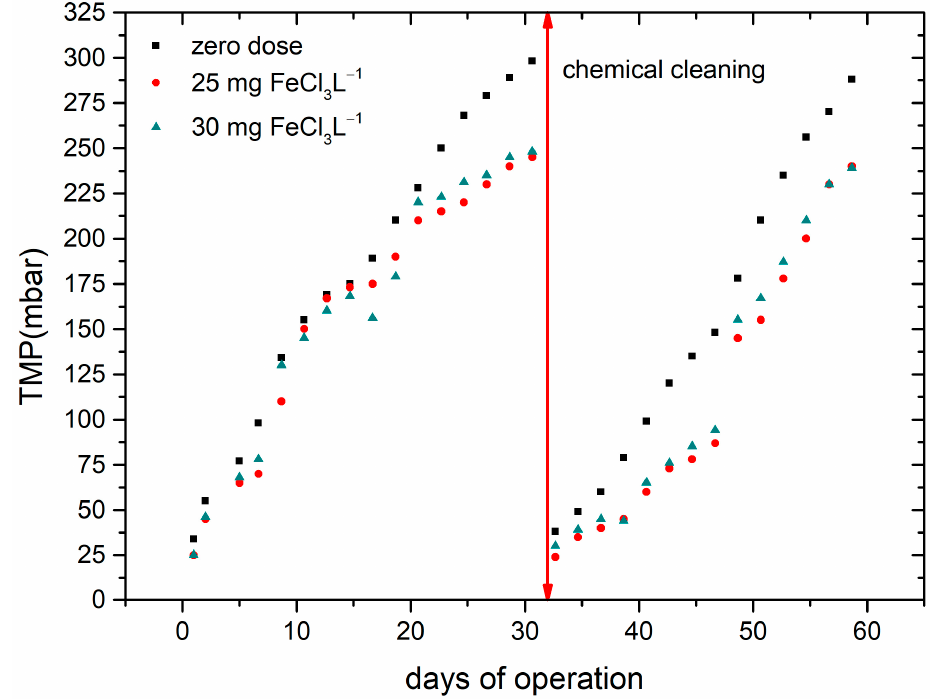
Figure 5. TMP pro fi le with and without FeCl 3 addition during winter period. Figure 5. TMP profile with and without FeCl 3 addition during winter